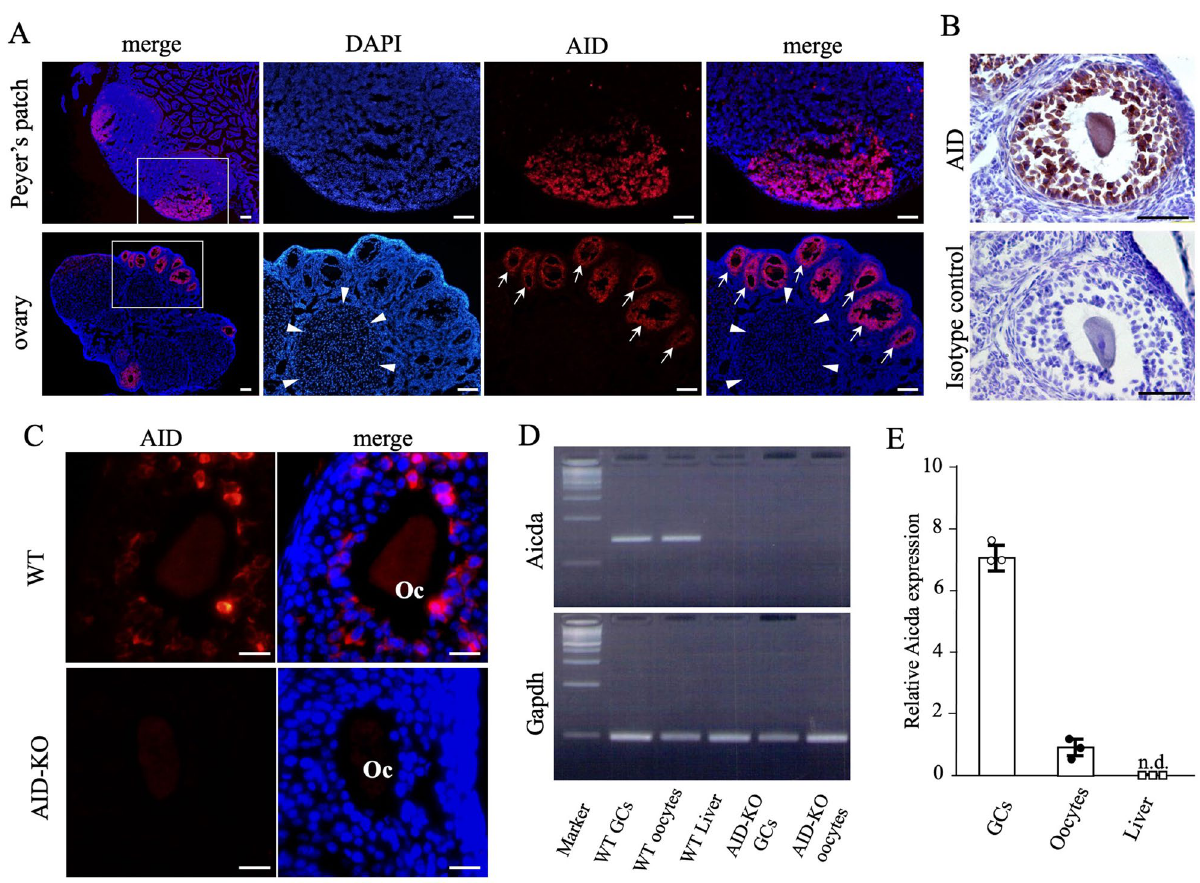
Figure 1. The expression profiles of AID protein in Peyer’s patches and ovaries. ( A ) Immunofluorescence of AID in 8-week-old mouse Peyer’s patches and ovaries. The right 3 panels show magnified views of the white square areas outlined in the left panel. AID was expressed in the germinal center of Peyer’s patches. Of note, AID was expressed only in follicles (arrows) and not expressed in the corpus luteum (arrowheads). Bars show 100 μm. ( B ) Immunohistochemical staining of AID in mouse follicles. Immunoreactive AID was observed in granulosa cells and oocytes. ( C ) AID staining of the ovaries using a different antibody in wild-type and AID-KO mice. AID was also observed in granulosa cells and oocytes (Oc), whereas no expression of AID was observed in the follicles of AID-KO mice. Bars show 20 μm. ( D ) RT-PCR analysis of AID and Gapdh mRNA expression. The mRNA expression of AID in granulosa cells and oocytes was confirmed. The data shown are representative of two independent experiments. Full-length gels are presented in Supplementary Figure S1. ( E ) Relative expression of AID in murine oocytes, granulosa cells, and liver cells as a negative control. AID mRNA expression in granulosa cells was higher than that in oocytes. Gapdh glyceraldehyde-3-phosphate